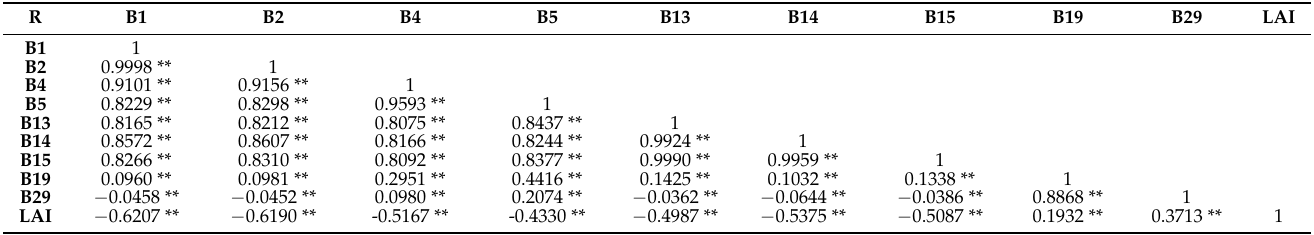
13 of 21 Table 5. Correlation between the optimal band combination and LAI. R